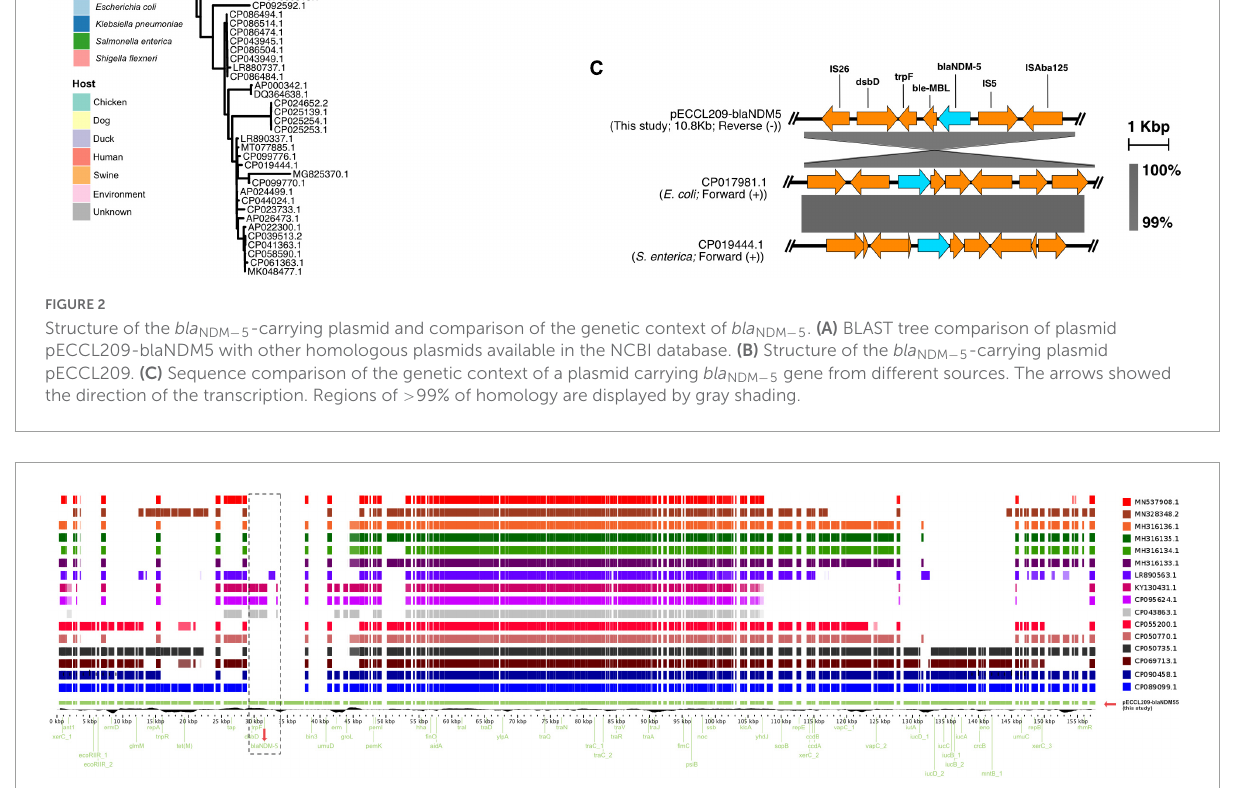
FIGURE3 Linear alignment of the selected bla NDM gene comparison with other homologous plasmids available in the NCBI